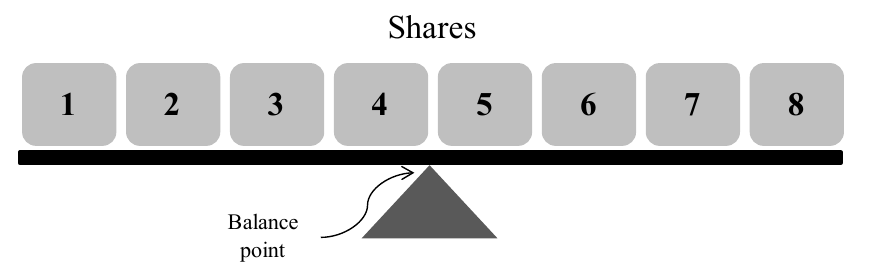
FIGURE 1 The maximum PDI in a hypothetical perfectly diversified portfolio Source: Gopi et al. (2006:7)